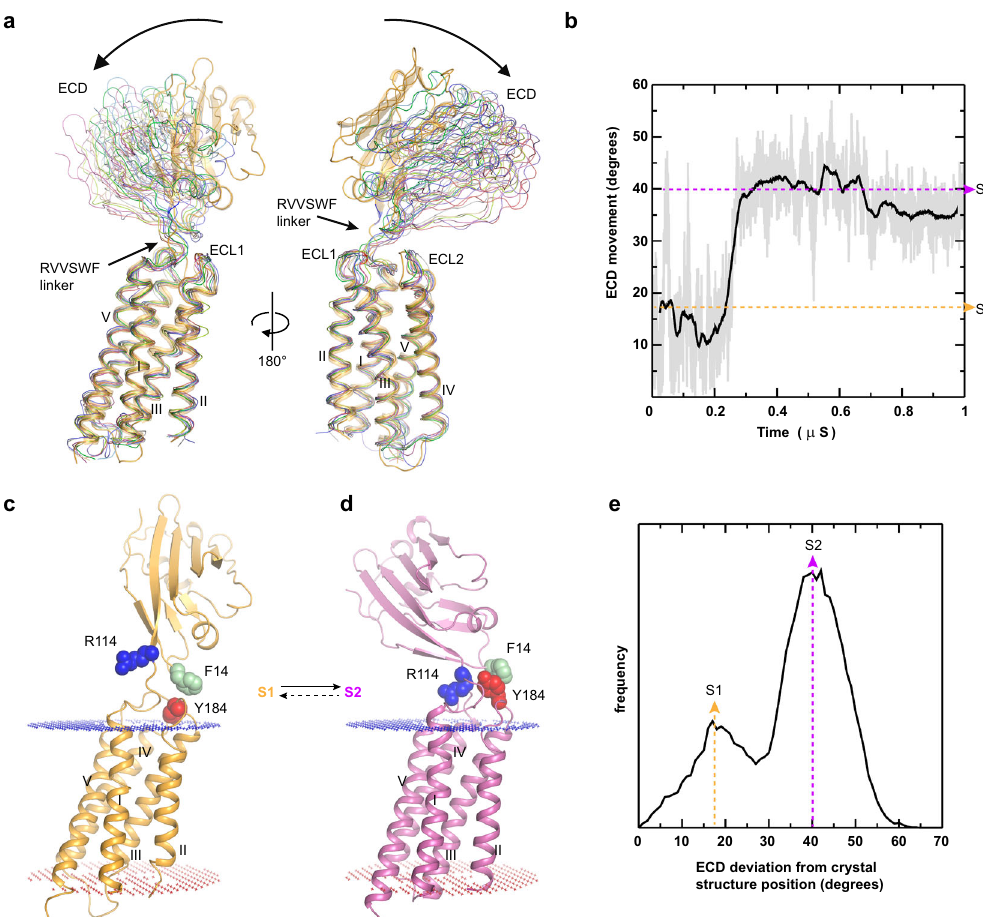
Fig. 6 CD47 macrostates. a Representative models of CD47 during the course of the molecular dynamics simulations taken at 0.1 μ s intervals (10 models shown) showing the range of motion of CD47 ECD. The CD47 crystal structure (starting model for the simulation) is shown as a yellow cartoon and the molecular dynamics models (0.1 – 1 μ s) are shown as thin tubes. b Plot showing the measured tilt (degrees) between ECD and TMD during the molecular dynamics simulations showing the transition from the s1 to s2 macrostates. The yellow (s1) and light pink (s2) dotted lines indicate the average ECD orientations in each macrostate. The gray line indicates the nanosecond fl uctuations and the black line the time average over every 1 ns within the single simulation trace. c – d Cartoon representations of full-length CD47 models from the simulations with ECD conformations corresponding to the average macrostates s1 (yellow) and s2 (light pink). The side chains of R114, Y184, and F14 are shown as blue, red, and light green spheres respectively. e Plot showing the frequency distribution of the ECD positioning with respect to the TMD (measured as the angle deviation, in degrees, from the crystal structure, which is the starting molecular dynamics model, time = 0 μ s). The yellow (s1) and pink (s2) dotted lines indicate the average ECD orientations in each